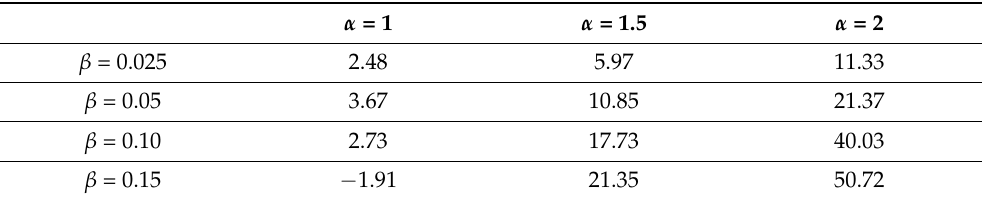
Table 1. Calculated performance index η W (%) of the inclusion R W = 0.1575 m. for waves of period T = 1.26 s, in water depth h = 0.7